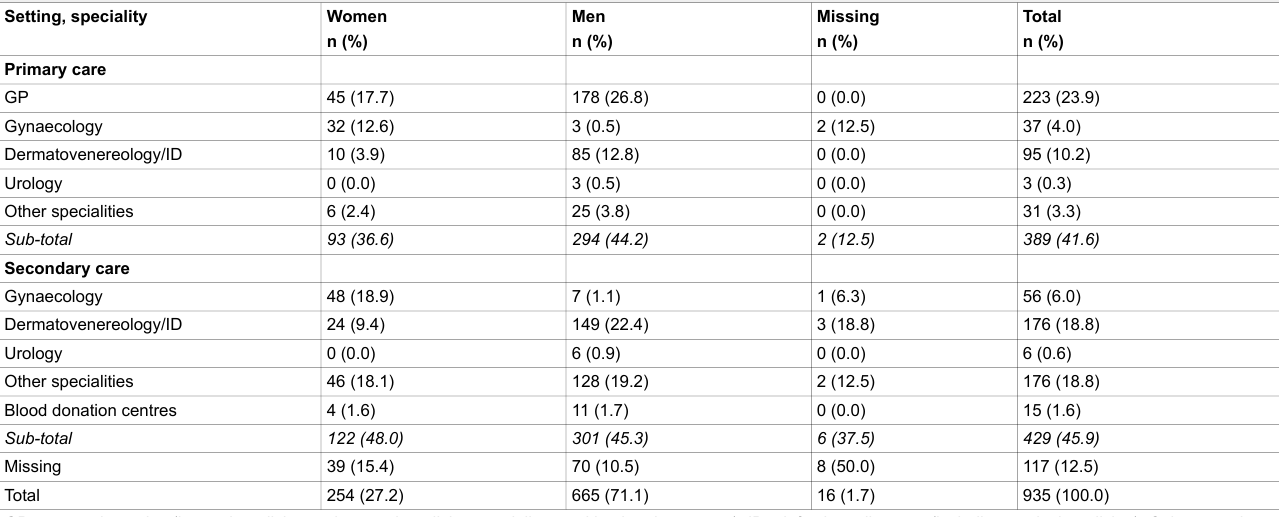
Table 3: Notifications of syphilis in women and men 01.07.2007–30.11.2008, by setting and speciality (N = 935). Setting,